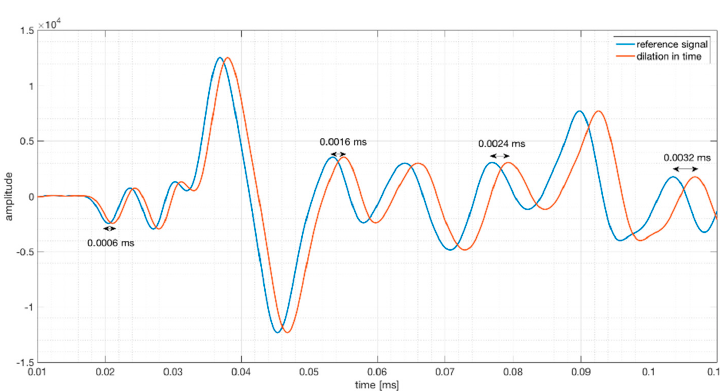
Figure 5. Signal with a dilatation factor ( α = 0.08) in time; the time difference increases over